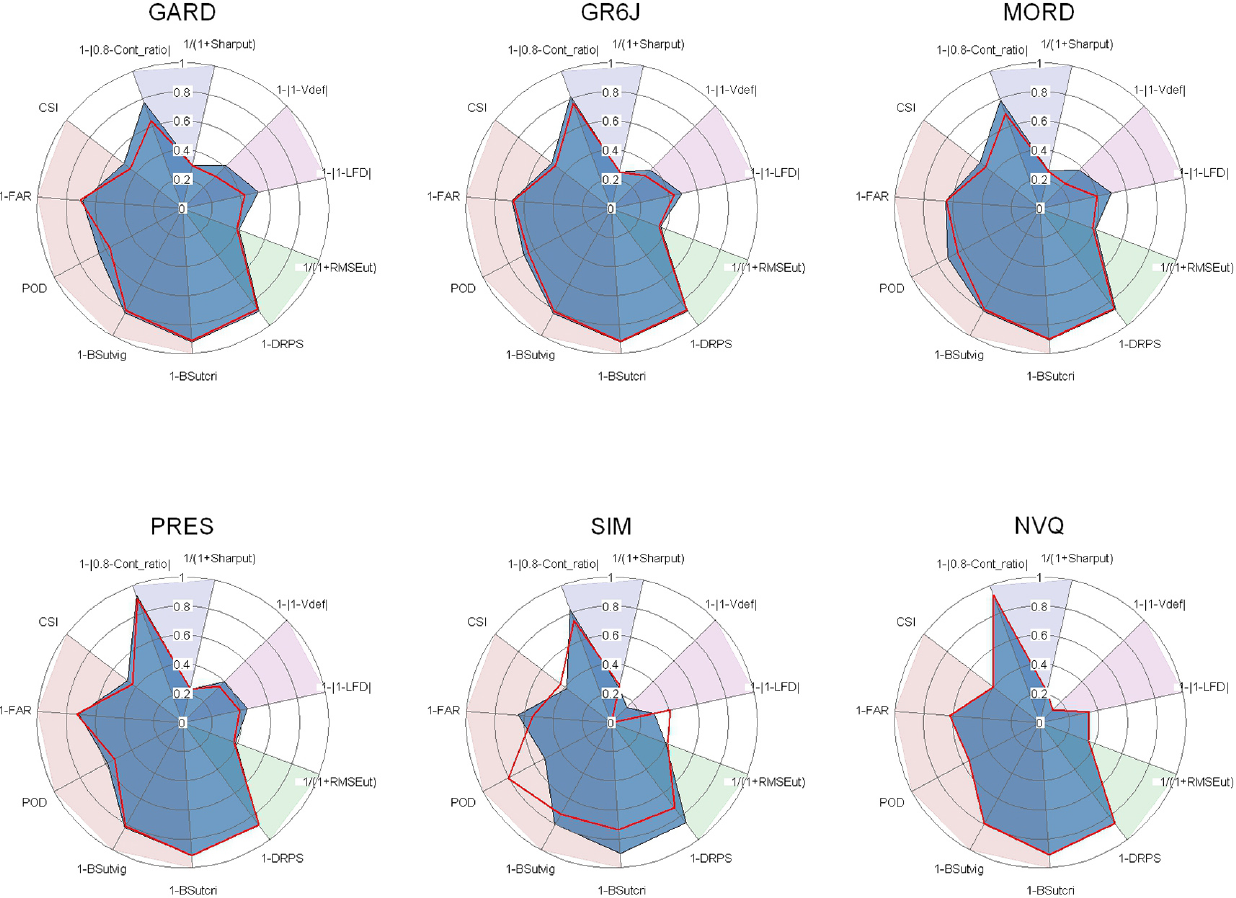
Figure 9. Radial plot of the mean model results for the 21 catchments for the selected criteria in validation period 2, for a d + 30 forecasting lead time. Red lines represent the results when no assimilation or post correction method is